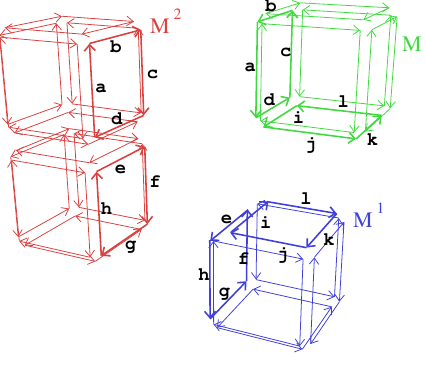
Figure 5. A 3-dmap DM that represents the 3-map of Figure 1b which has been decomposed into 3 blocks M 1 , M 2 , M 3 . Critical darts are labeled with lowercase letters a , ..., l , and are drawn in